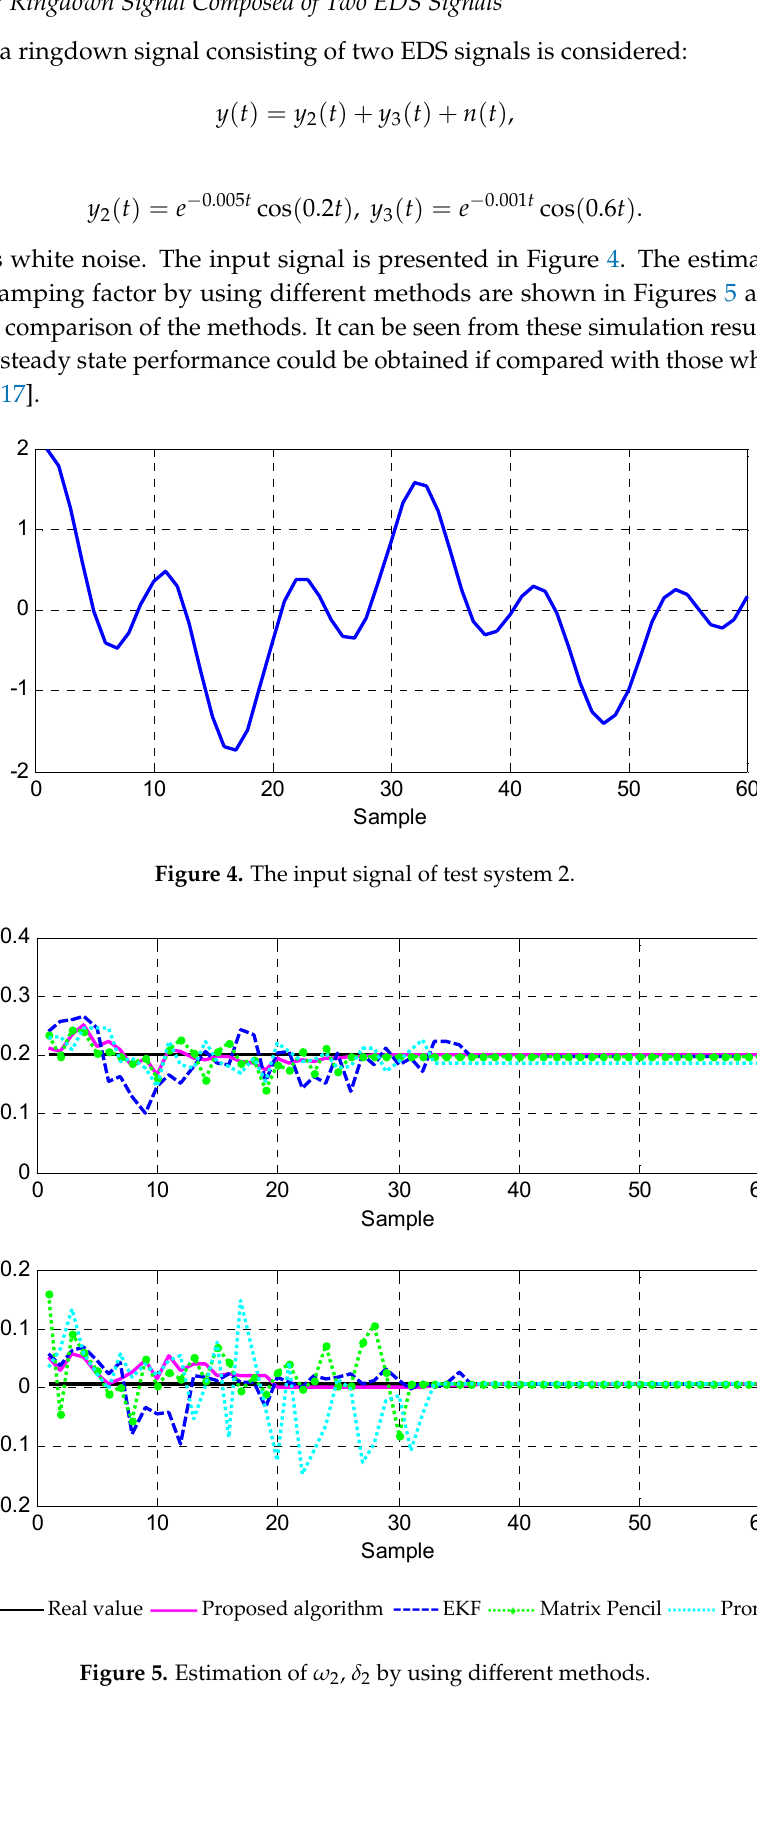
Figure 5. Estimation of ω 2 , δ 2 by using different